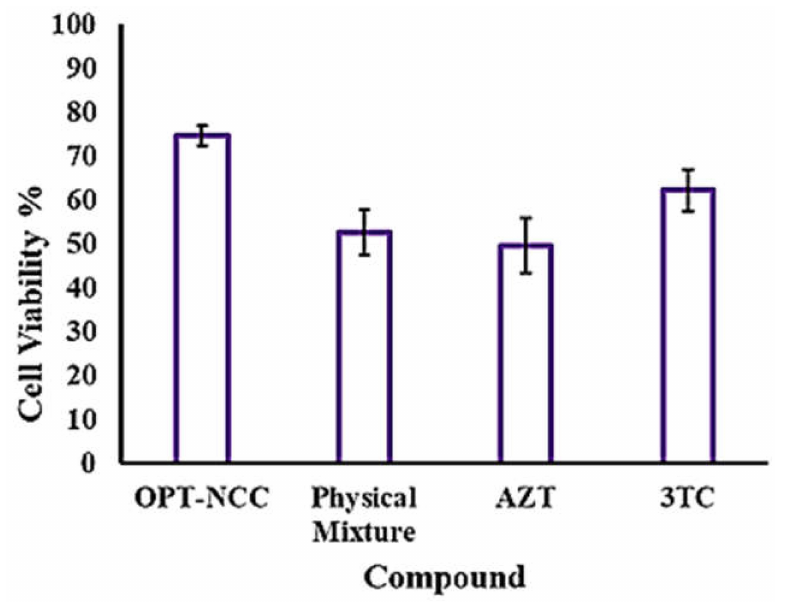
Figure 8. Comparison of cytotoxicity assays of OPT-NCC, lamivudine (3TC), zidovudine (AZT), and physical